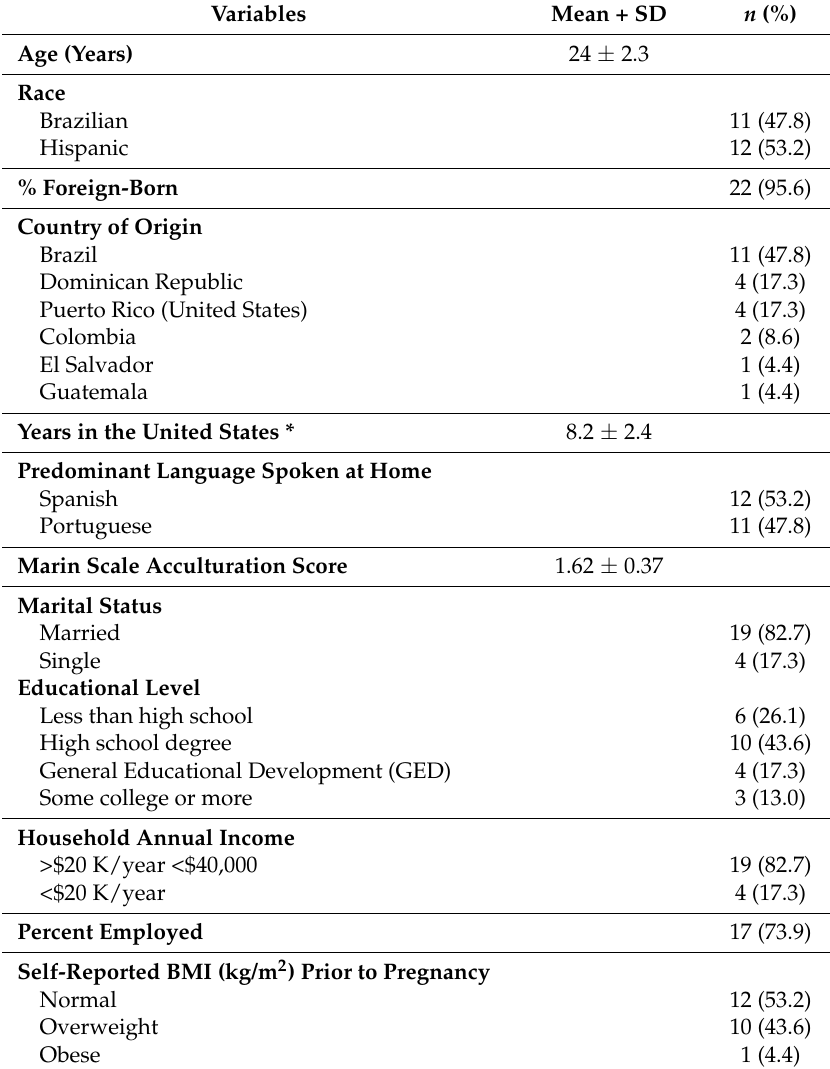
Table 1. Socio-demographic and acculturation characteristics and self-reported weight status of study participants ( n =